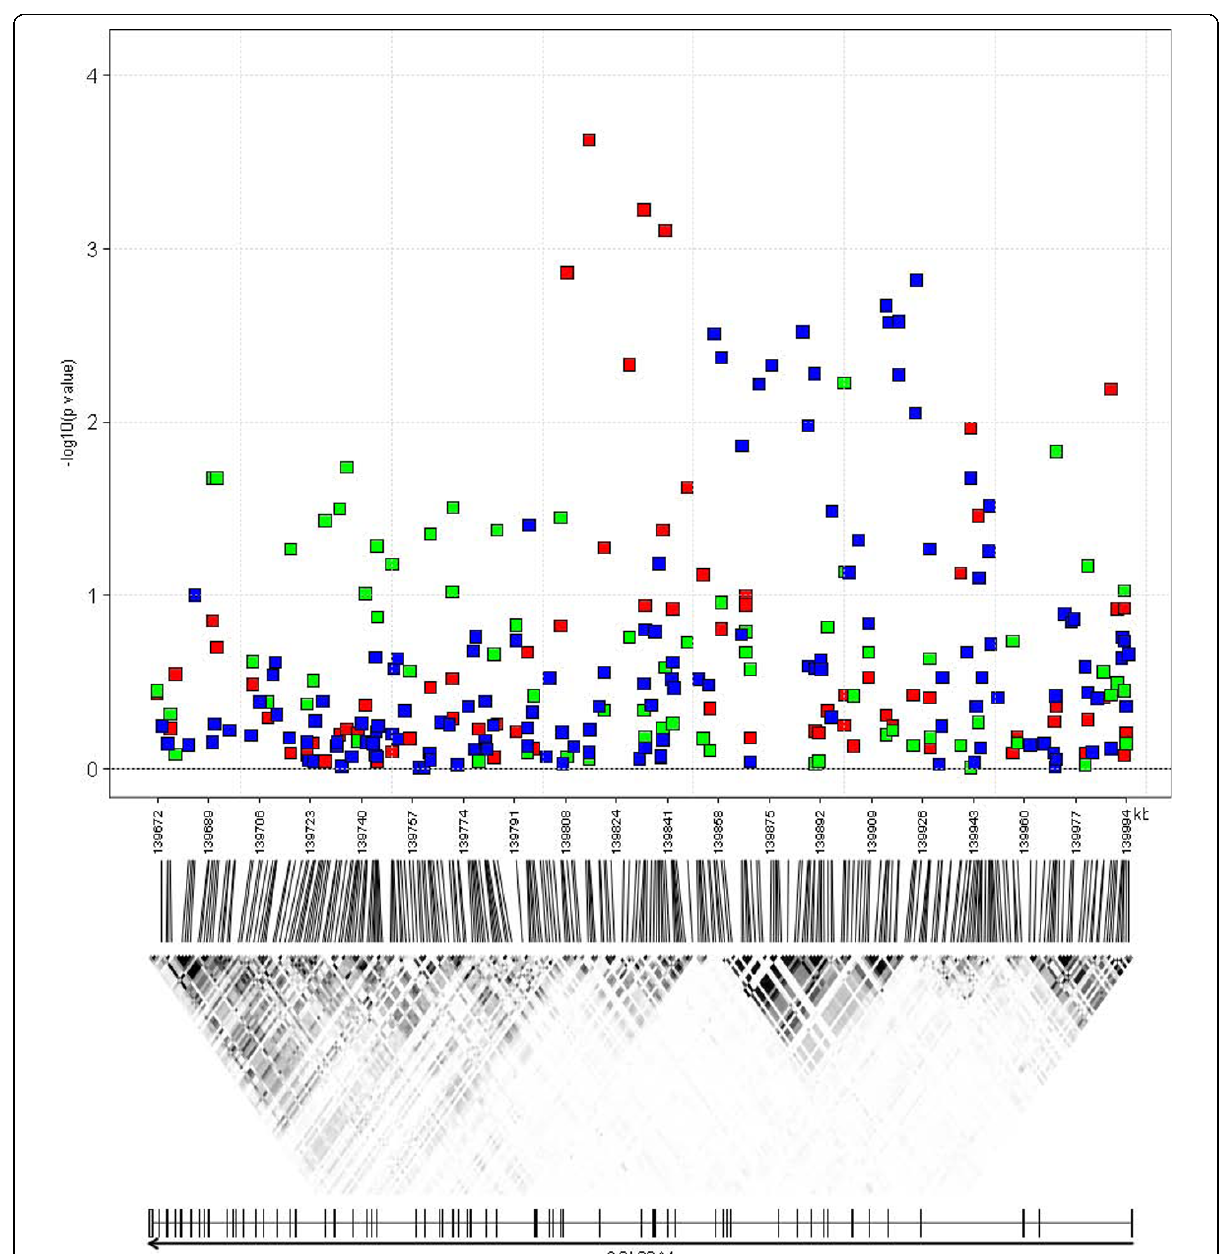
Figure 5 Genomic structure and association results at the COL22A1 locus . Upper panel : -log 10 (p values) are plotted by physical position for the EUROSPAN discovery meta-analysis (red squares), the popgen (blue squares) and the Korcula (green squares) replication cohorts. Middle panel : linkage disequilibrium (LD) as quantified by r 2 (the higher the LD, the darker the color, with black indicating perfect LD), based upon the HapMap-CEU database, Phase III/Release 2, (NCBI build 36). Lower panel : genes located in the plotted region, with coding exons indicated by black rectangles and